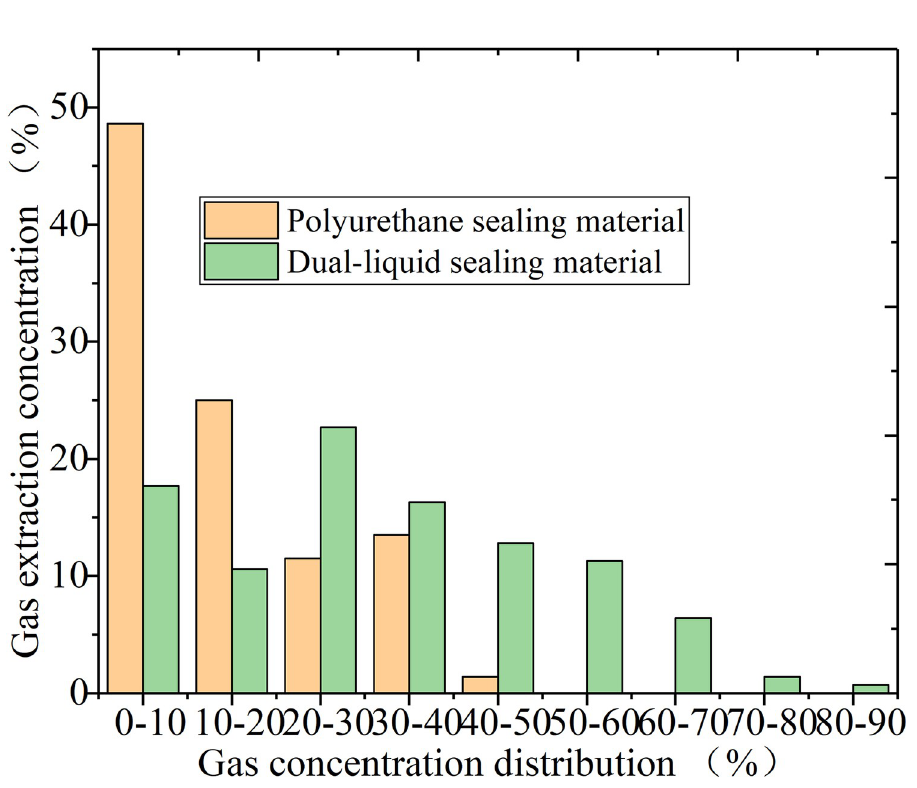
Fig 19. Gas concentration frequency statistics comparison chart.